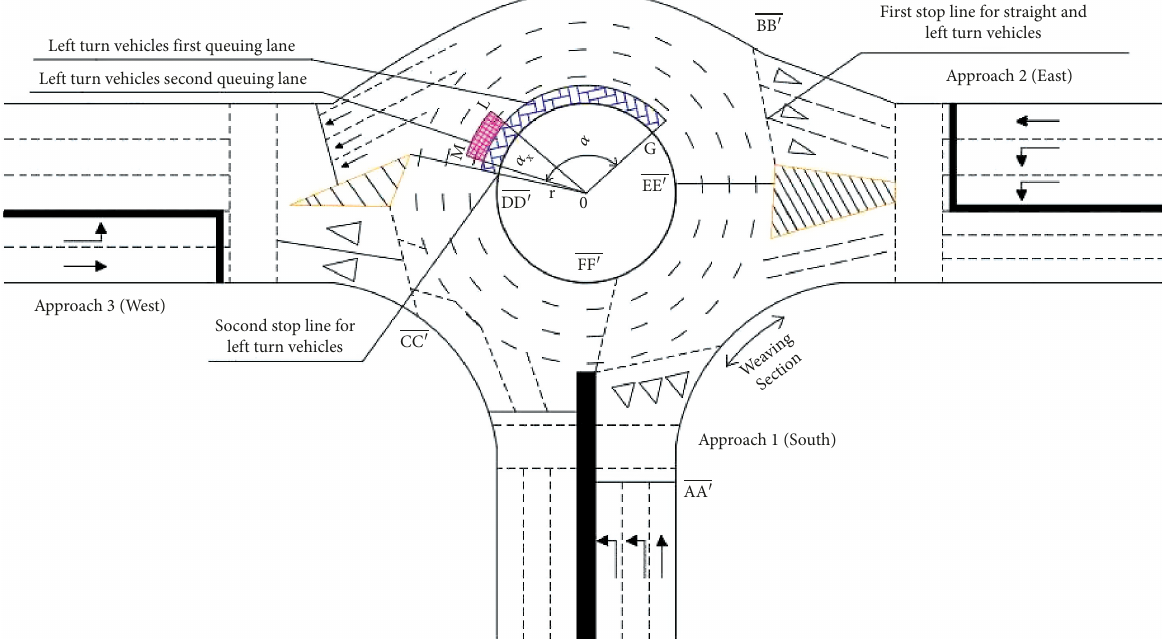
Figure 3: Internal space constraint of primary and secondary roadways.